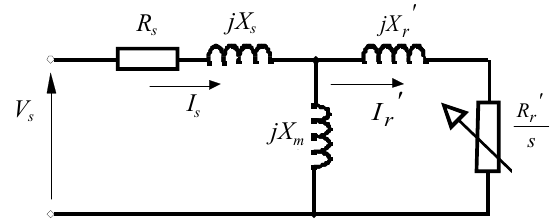
Figure 4. Steinmetz T-equivalent diagram of induction motor.